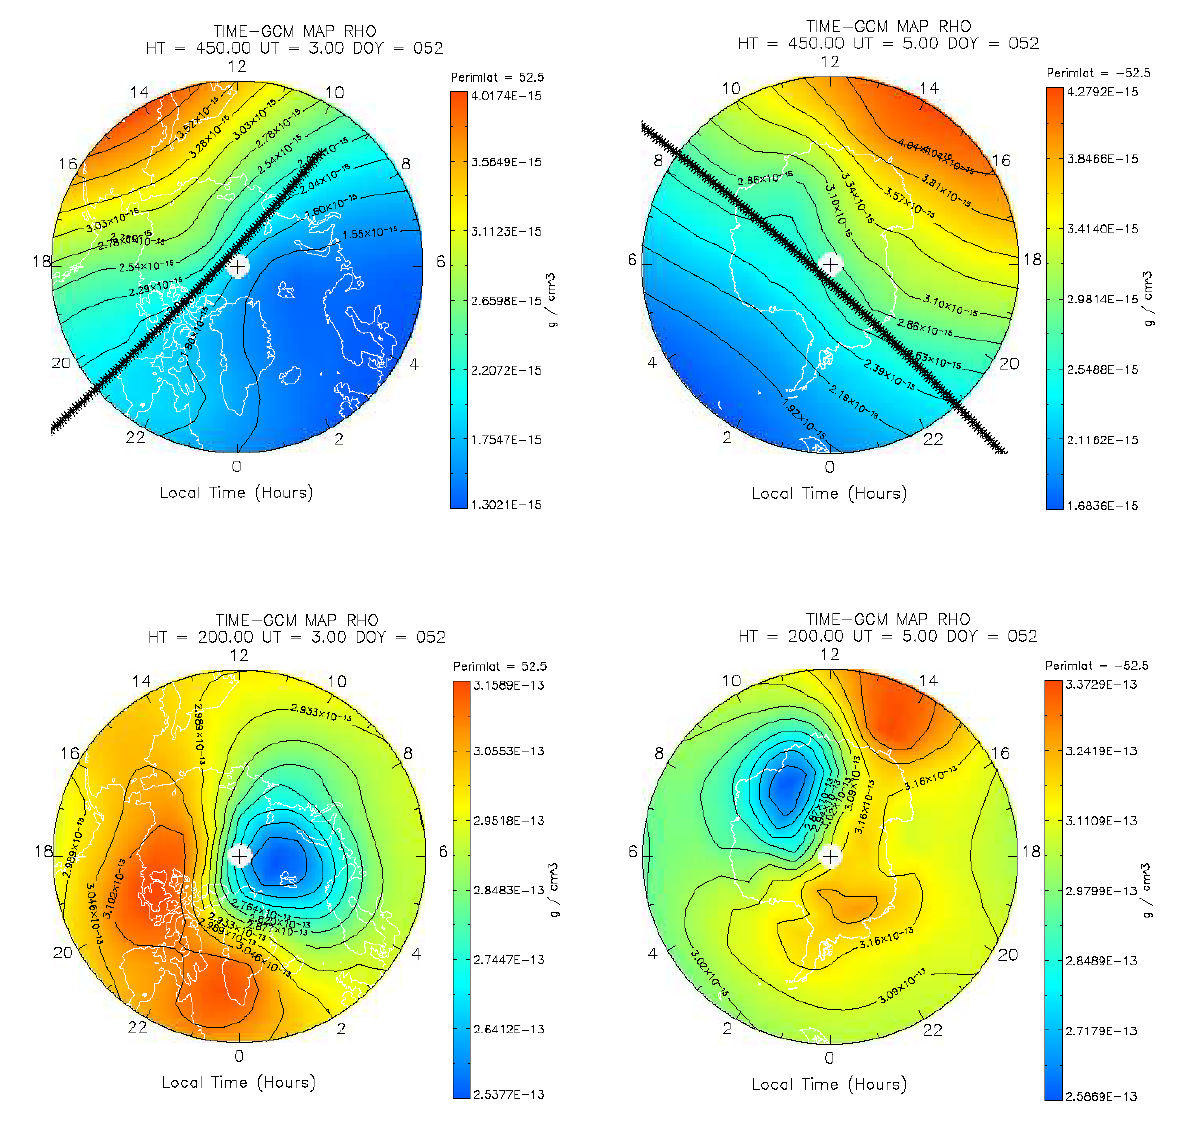
Fig. 8. Results from the TGCM model for the 21 February 2002. The upper row shows the density at 450km altitude over the Northern (right) and the Southern (left) Hemisphere, the CHAMP trajectory is indicated with crosses. The lower row shows the density at 200km altitude for both hemispheres, clearly structured in “cells”. Perimeter latitudes are 52.5 ◦ N and 52.5 ◦ S.